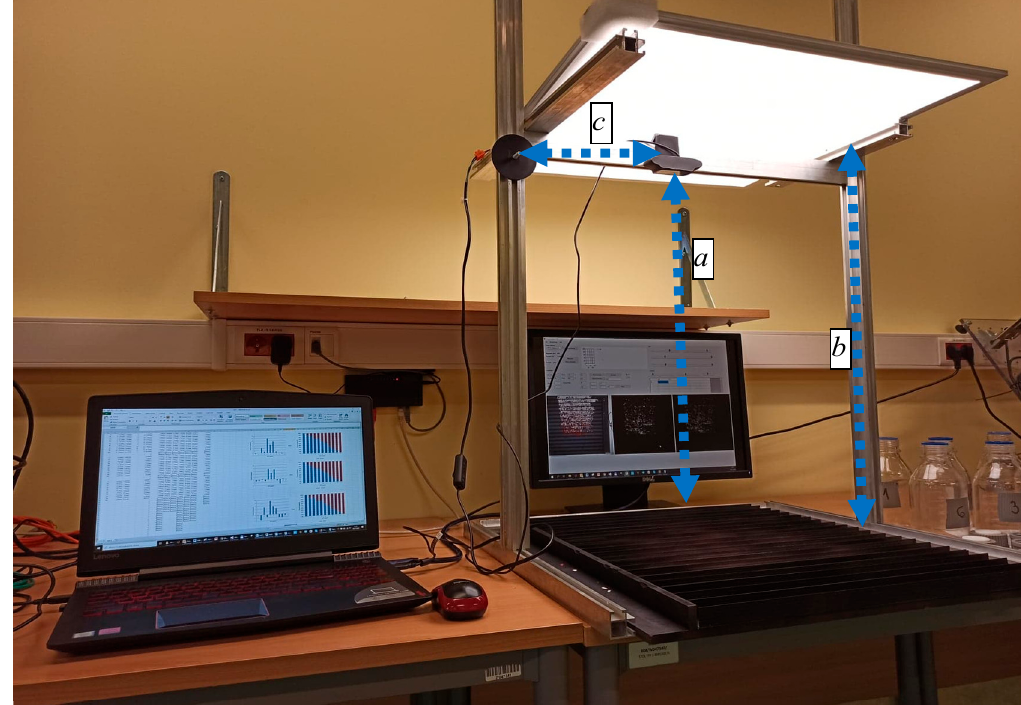
Figure 3. Test rig and components of the developed vision system.